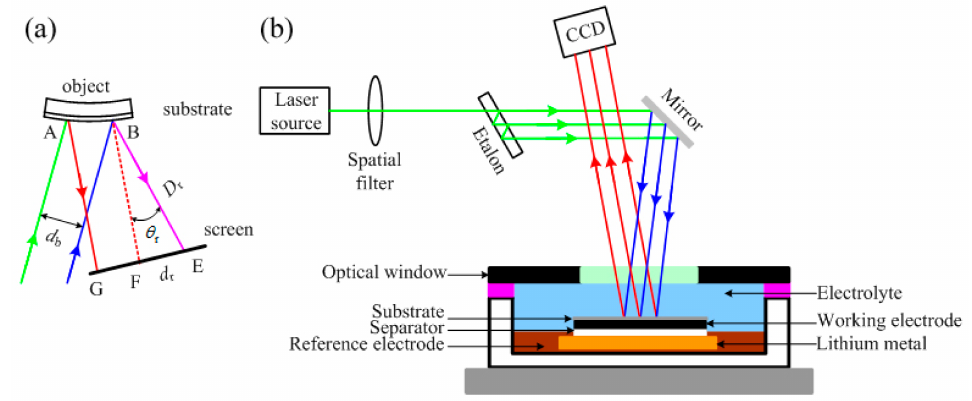
Figure 4. Theory of MOSS technique. ( a ) If two light beams strike on two different positions of a curved object under measurement, the distance between their reflections depends on the curvature of the reflecting surface. The curvature radius R k is linked to the distance between the reflections d r according to R k = 2D r d b /(rcos θ r ). ( b ) Using more than two parallel light beams, the distance between adjacent beams can be mediated to reduce the measurement error. A linear array of multi-beams can be obtained using an etalon, an optical element having highly reflective and parallel faces. Using this approach, it is possible to monitor the evolution of stress on a planar or curved objects. Figure reproduced from